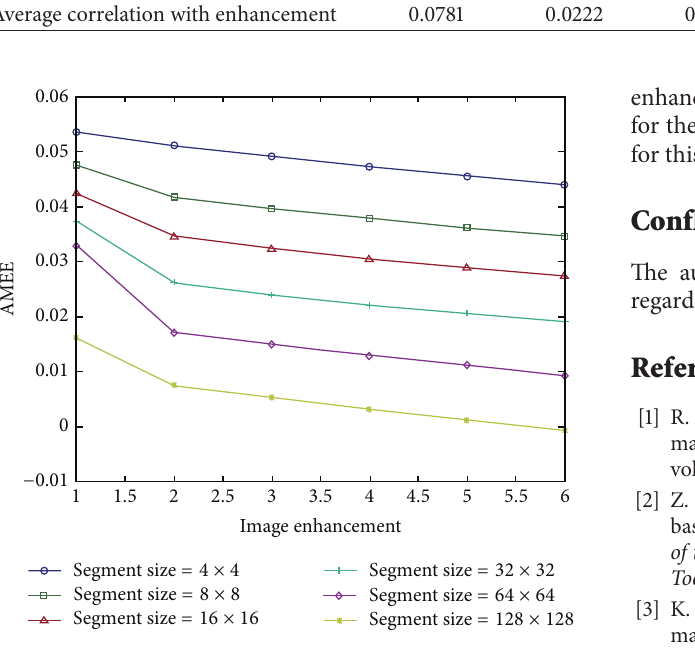
Figure 4: Enhanced image from Figure 3 was tested by AMEE measure. Higher image index ( 𝑥 -axis) means higher image contrast; also lower AMEE measure ( 𝑦 -axis) indicates more enhanced